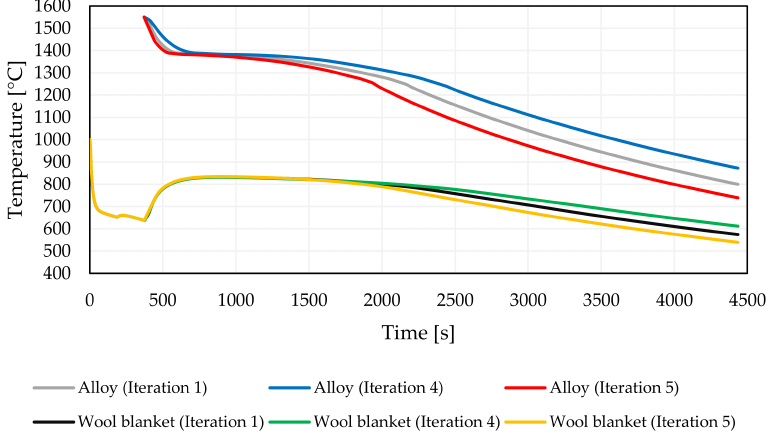
Figure 14. Evaluation of the influence of thermal conductivity on the alloy and wool blanket temper- ature